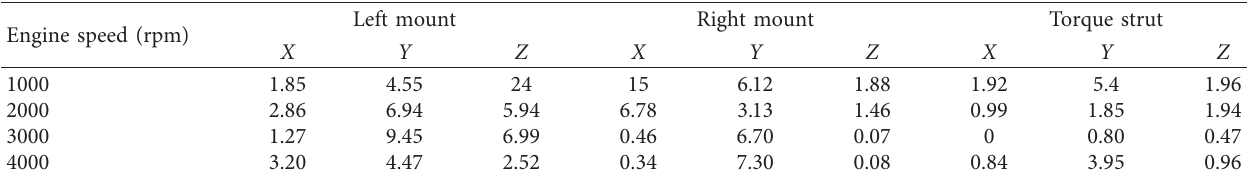
Engine speed (rpm)